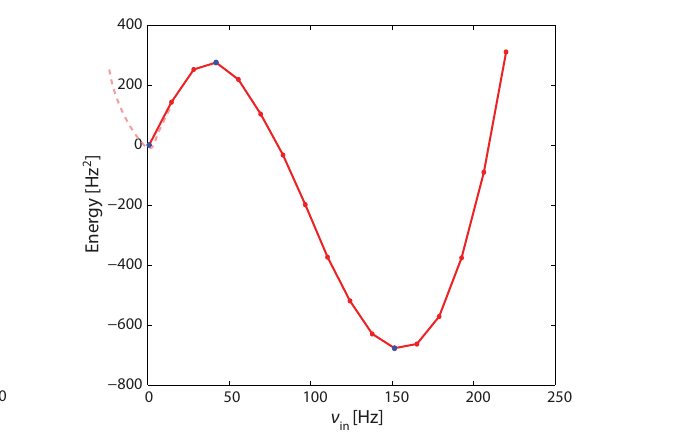
ERF and the diagonal (black line) predict fixed points of the network dynamics (stable or unstable). Note that these predictions are approximate (inset). Right panel : “Double-well” energy landscape derived from the ERF (see text for details). Energy minima (maxima) correspond to stable (unstable) fixed points of the network dynamics.